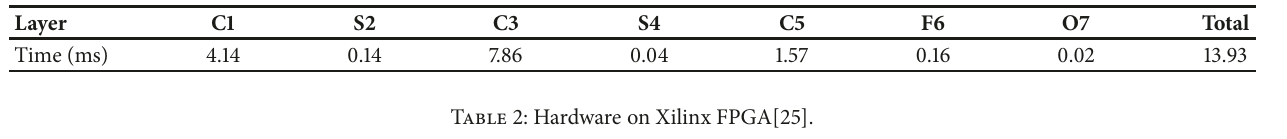
Table 1: The single thread calculation time of the LeNet-5 layers on CPU.